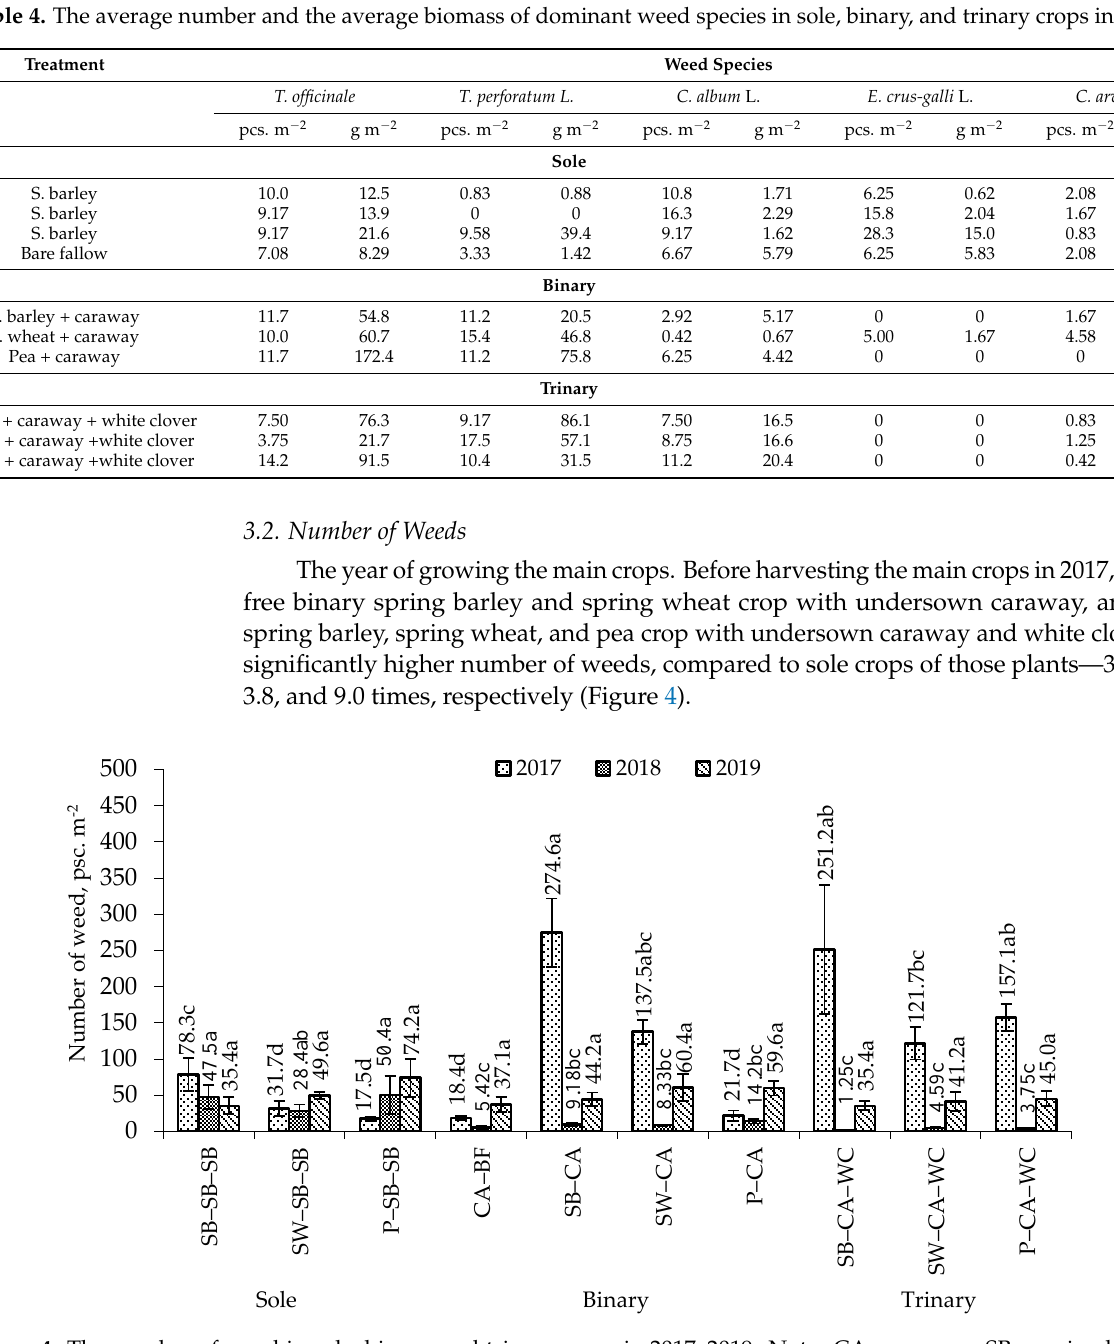
Figure 4. The number of weed in sole, binary, and trinary crops in 2017–2019. Note. CA—caraway, SB—spring barley, SW —spring wheat, P—pea, WC—white clover, BF—black fallow. Differences between the averages of treatments marked with different letters (a, b, c, d) are significant ( p < 0.05); error bars indicate the standard error.